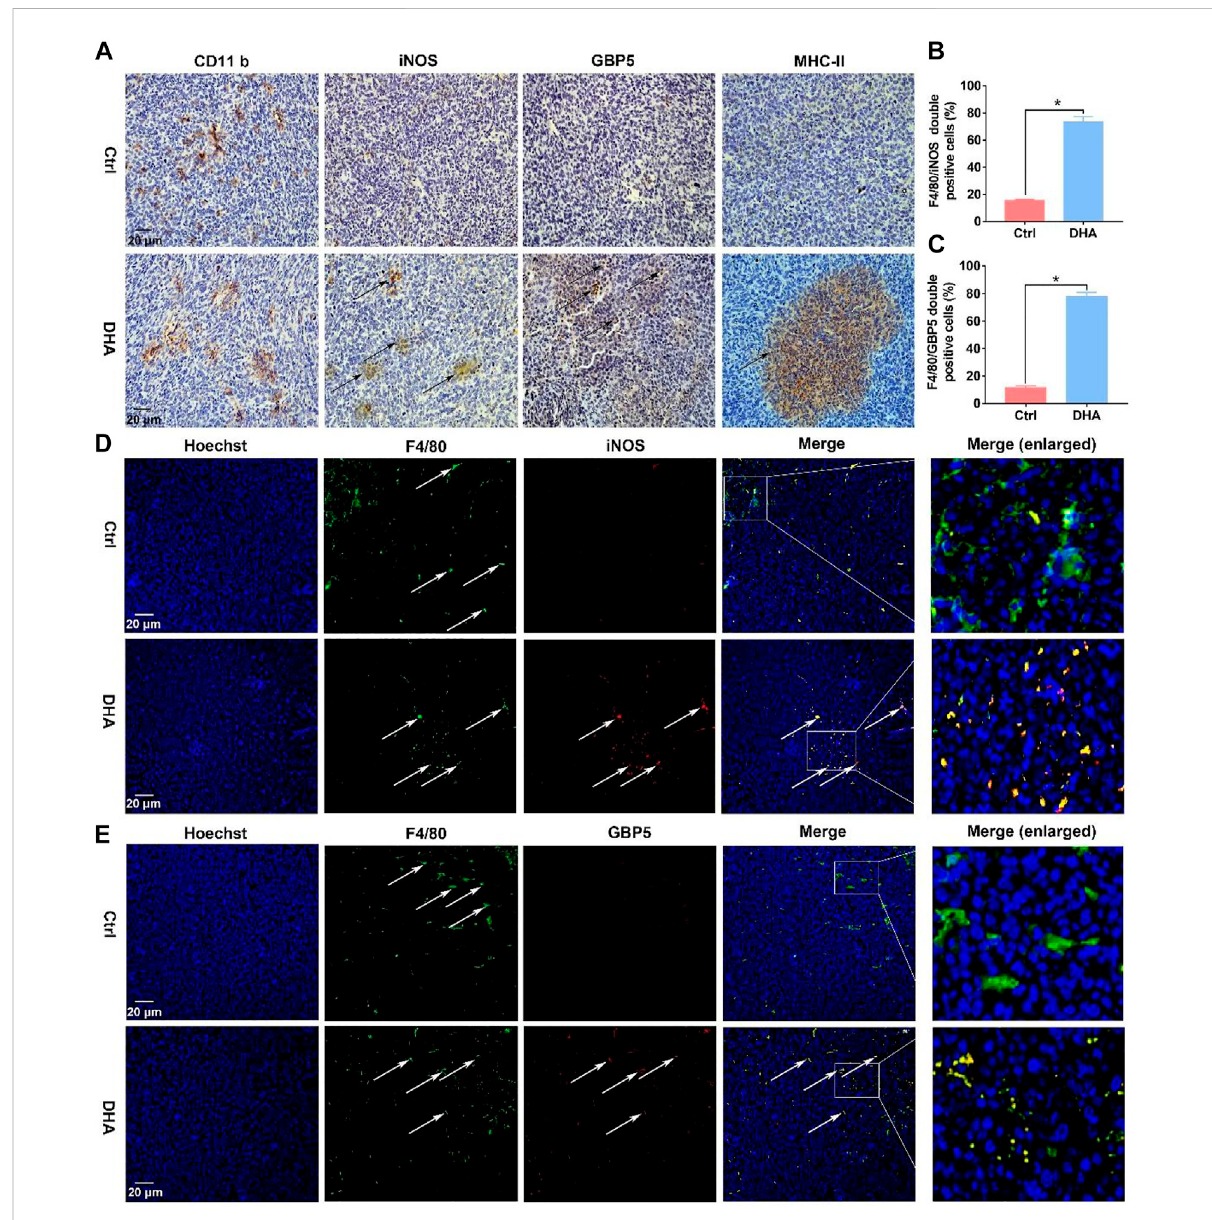
FIGURE 2 DHAreprogrammed macrophages intotheM1phenotype intumortissues. (A) The expression ofCD11b,which isabiomarkerofmacrophages, was assayed by IHC. In addition, M1 phenotypic molecules, such as iNOS, MHC-II, and GBP5, were detected through IHC as well. (B,C) F4/80/iNOS and F4/80/GBP5 double-positive cells in the tumor grafts were counted. (D,E) The in fi ltration and phenotypic remodeling of macrophages were assayedbymultipleimmuno fl uorescentstainingofF4/80andiNOS,GBP5.Green fl uorescencecamefromF4/80.Red fl uorescencecamefrom iNOS or GBP5. Yellow fl uorescence represented F4/80/iNOS or F4/80/GBP5 double-positive cells (type-I macrophages). Values were means ± SD ( n = 3, * p < 0.05 when compared with the control